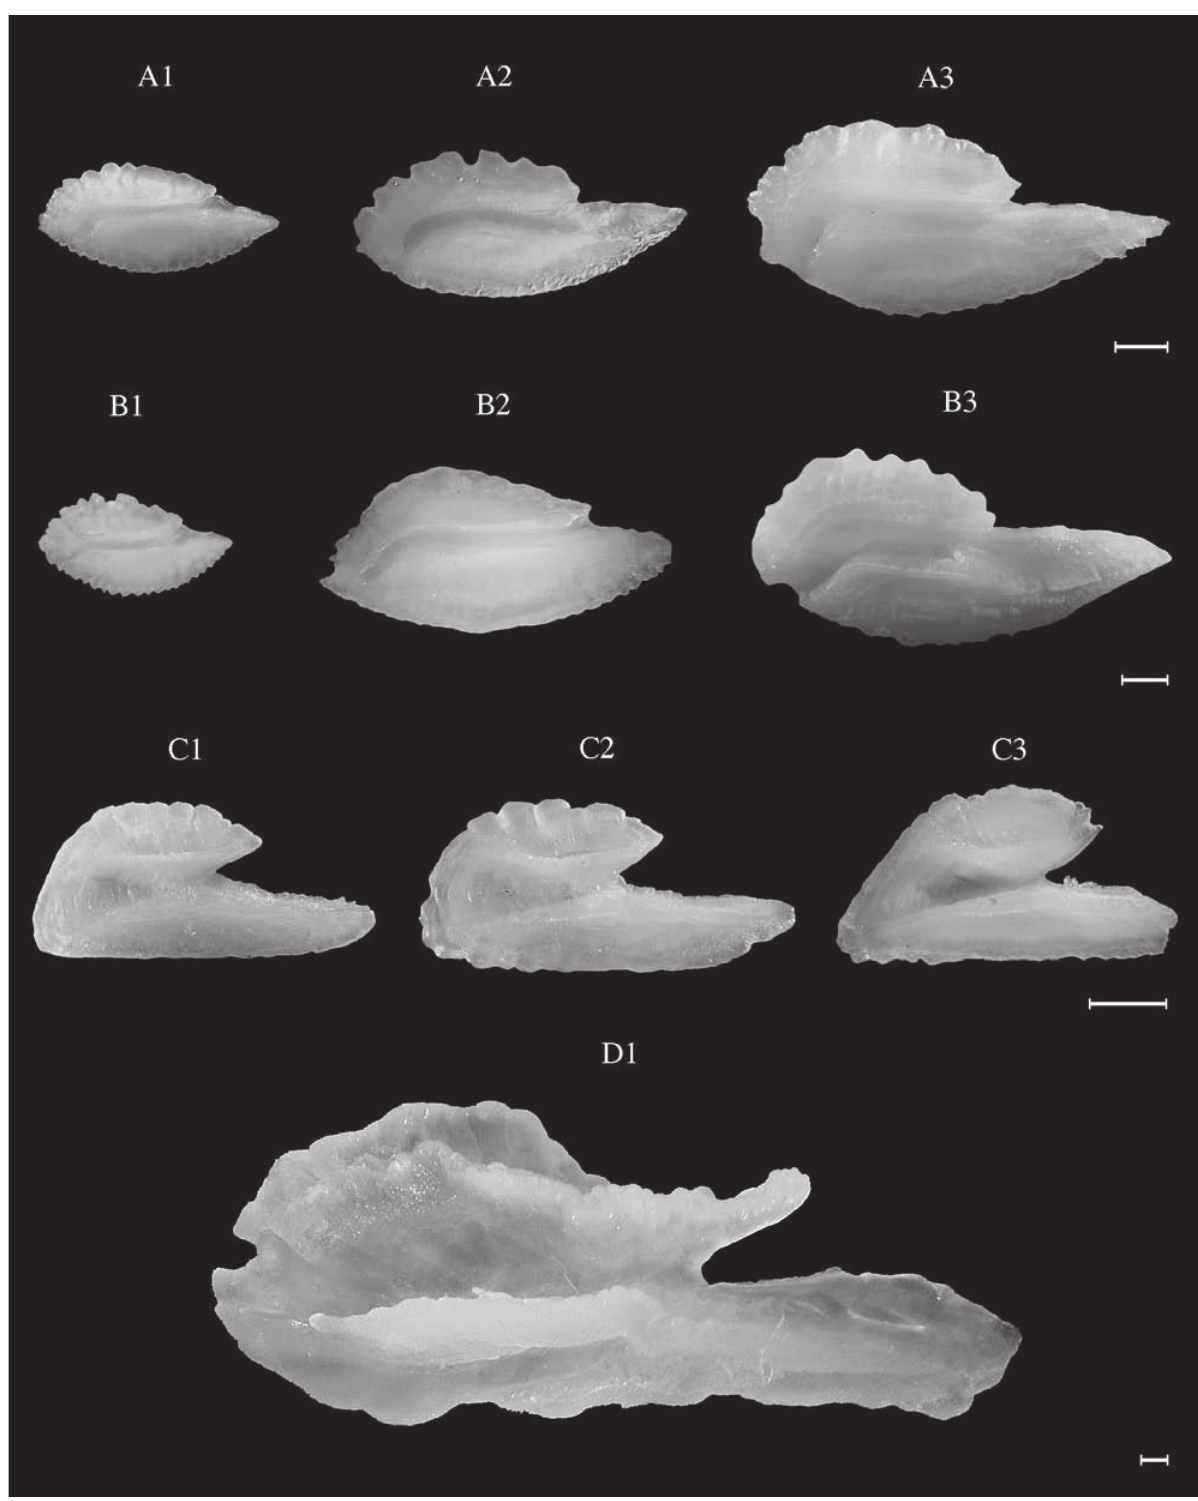
Fig. 54. – Trachurus picturatus . TL: A1, 16.0 cm (NEA); A2, 23.0 cm (WM); A3, 31.7 cm (NEA). Trachurus trachurus . TL: B1, 12.5 cm (CEA); B2, 26.5 cm (WM); B3, 48.7 cm (NEA). Brama brama . TL: C1, 32.9 cm (NEA); C2, 44.7 cm (NEA); C3, 52.5 cm (CEA). Taractichthys longipinnis (CEA). TL: D1, 78.3 cm. Scale bar = 1